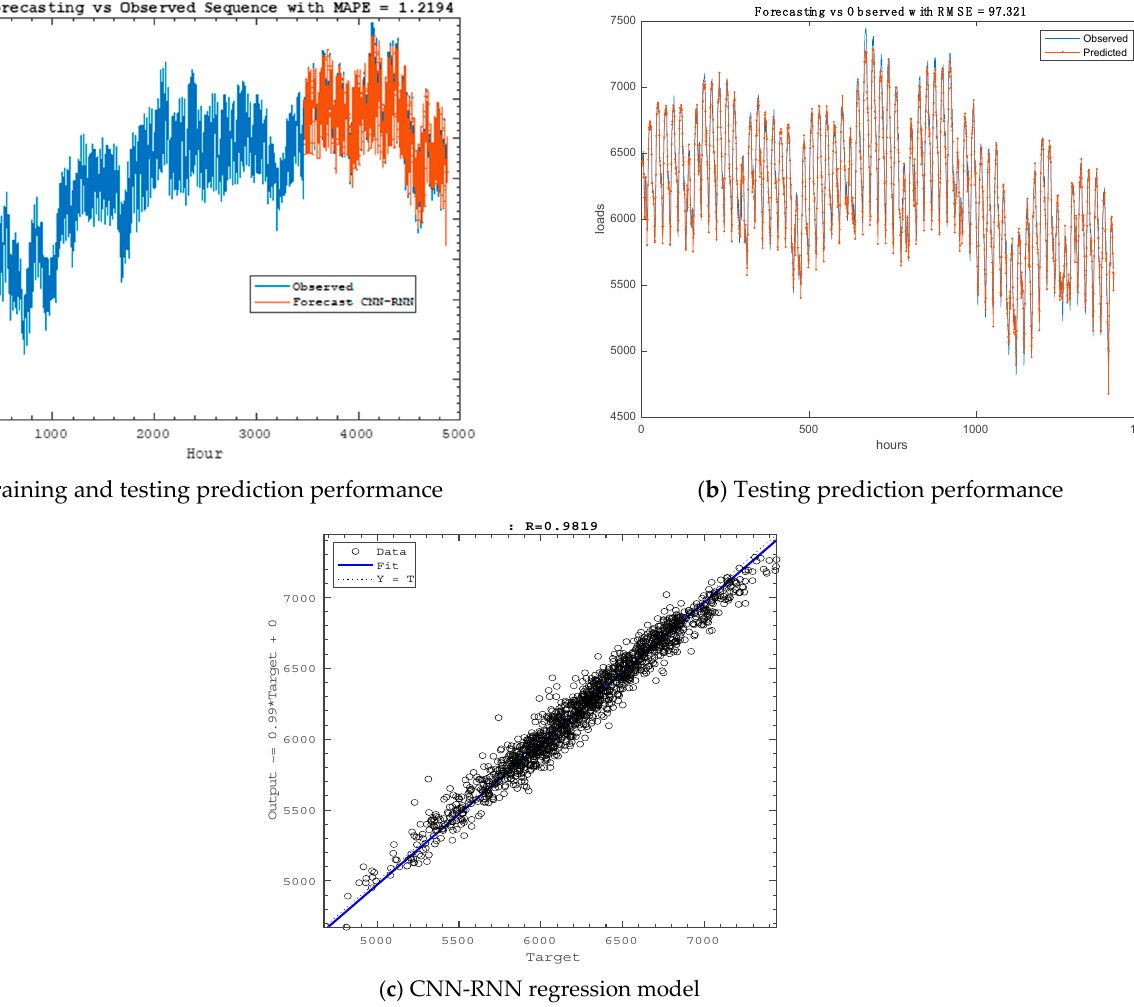
Figure 12. CNN-RNN model prediction performance for Jeddah load: ( a ) training and testing, ( b ) testing, and ( c ) regression plot.